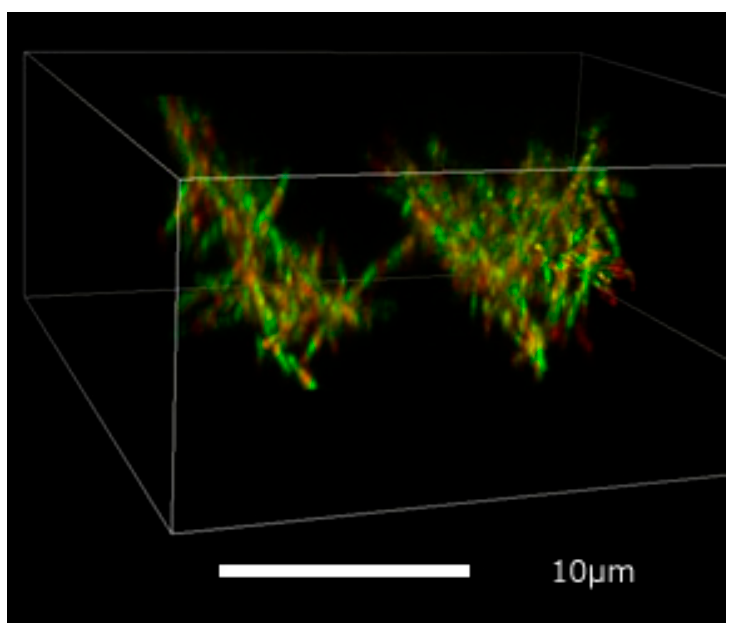
Figure 3. A volume rendering for the obtained 3D depth slice image dataset by CLSM. Microtubule filaments stacks were inclined toward each other. Background noise was visually decreased by low signal level cut off. The white rectangle box is 35 × 35 × 14 μ m.